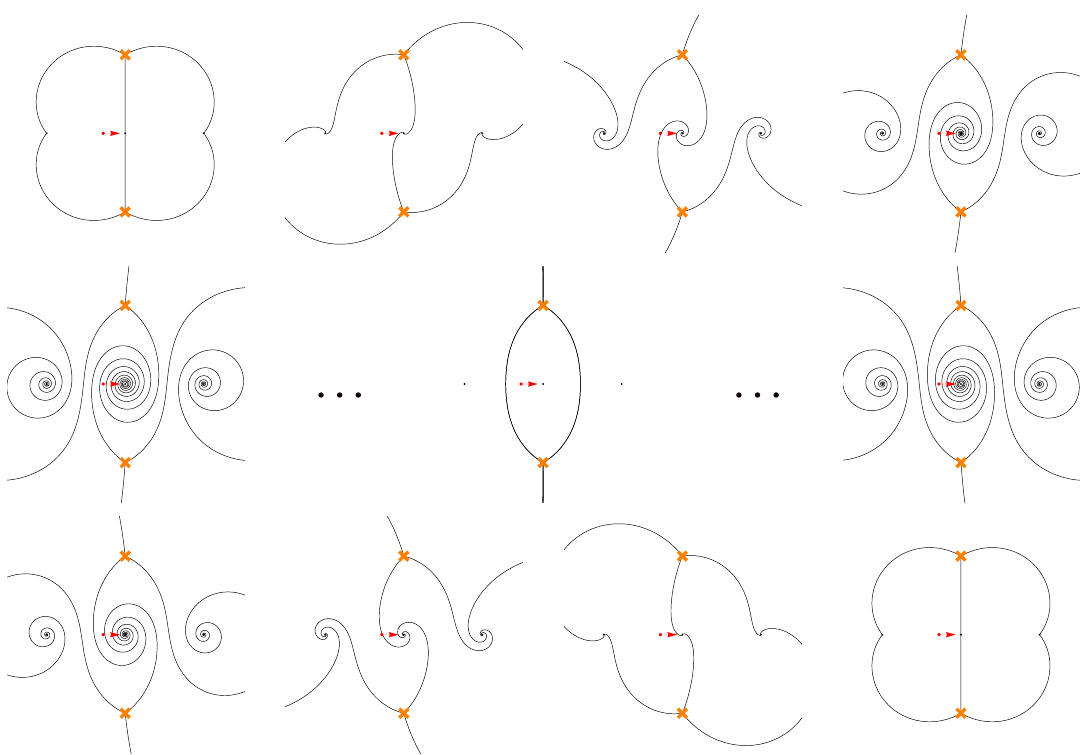
Figure 10. Sequence of spectral networks of the T 2 theory. The phases begin with sector I as described in (3.22), for phases ranging from # c (cid:0) (cid:25)= 2 (top-left) up to # c (center), and proceeds with phases from sector II , as described in (3.25), ranging from # c to # c + (cid:25)= 2